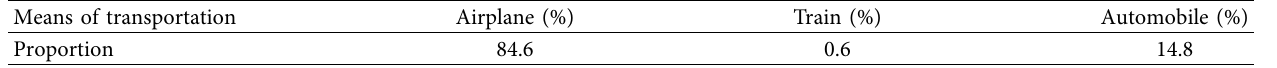
Table 1: Weights index at different levels.